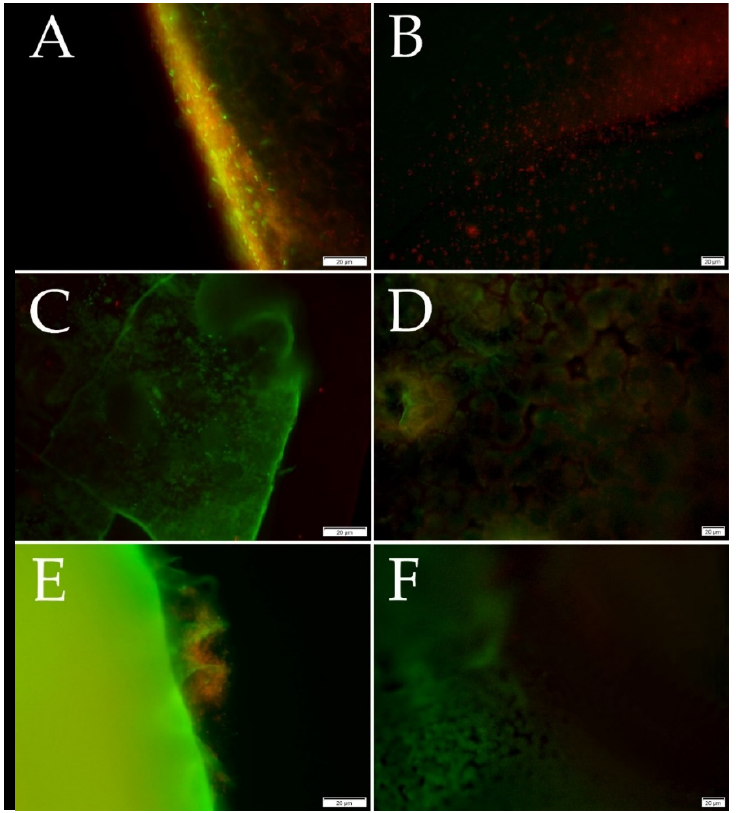
Figure 1. Fluorescence microscopy of LIVE/DEAD bacterial viability assay with Stenotrophomonas maltophilia . ( A ): PLA, ( B ): PLA/T, ( C ): PBS, ( D ): PBS/T, ( E ): PBAT, ( F ): PBAT/T. PLA: poly(lactic) acid, PBAT: poly(butylene adipate-co-terephthalate), PBS: poly(butylene succinate), T: 3% w / v thymol.